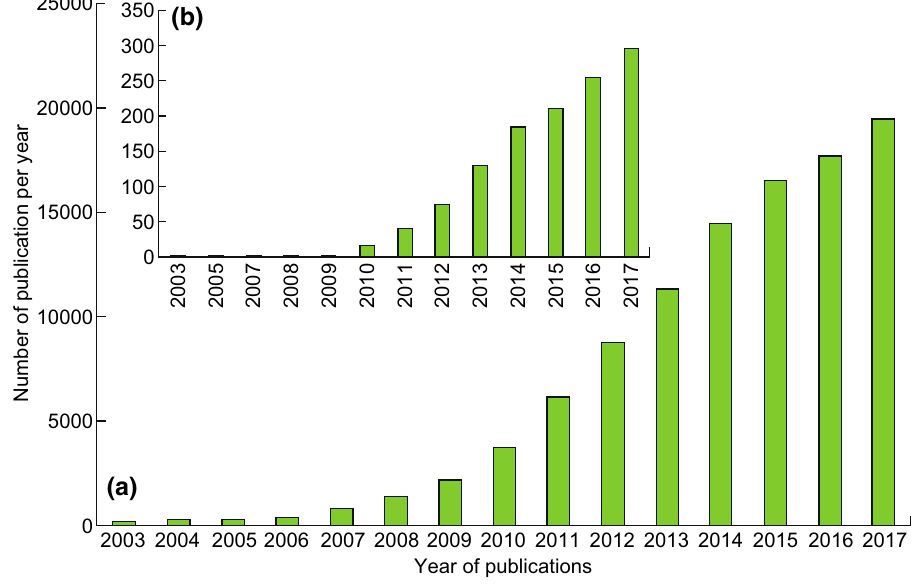
Fig. 1 a Graphical analysis of a number of publications on ‘graphene’ and b ‘biomedical applications of graphene’ for the past 14 years. Data retrieved from